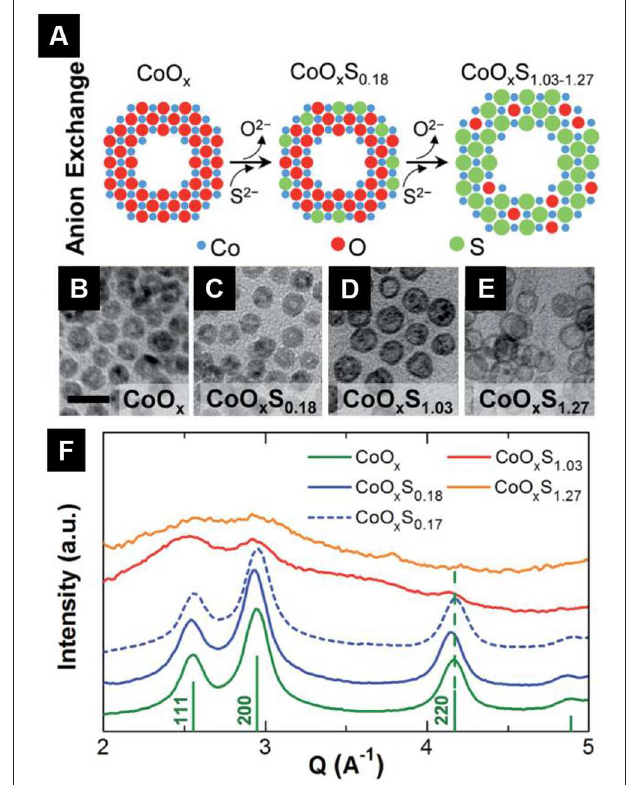
FIGURE 17 | Adapted from Nelson et al. (2016) (A) Synthetic strategy of CoO x S y hollow nanoparticles. TEM micrographs of CoO x S y nanoparticles with y = 0 (B) ; 0.18 (C) ; 1.03 (D) ; 1.27 (E) . (F) Rotationally averaged SAED patterns of the various CoO x S y nanoparticles. Reference lines in green indicate CoO Bragg peaks (JCPDS 00-048-1719). Adapted from Nelson et al. (2016) with permission of the Royal Chemical